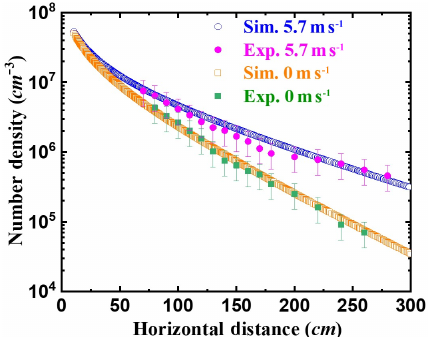
Figure 5. The effect of wind on the distribution of ions generated by a single corona discharge point (indoor tests). Wind speed at 0 and 5.7ms − 1 . The applied voltage on the wire electrode was − 40kV. The experiment measurement data are plotted as error bars. The simulation data are plotted as hollow